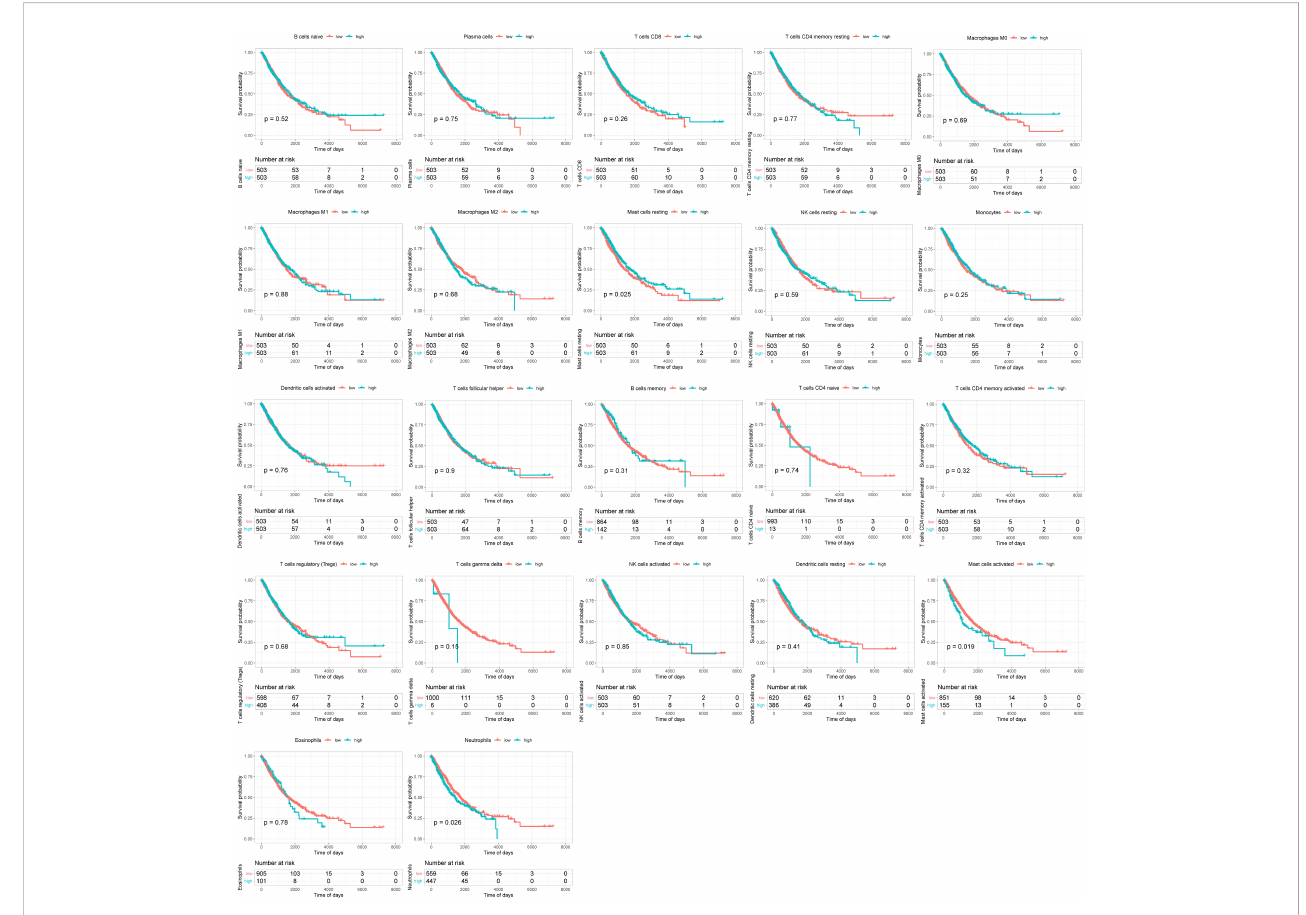
FIGURE 2 Survival analysis of in fi ltrated immune cells between high- and low-in fi ltration